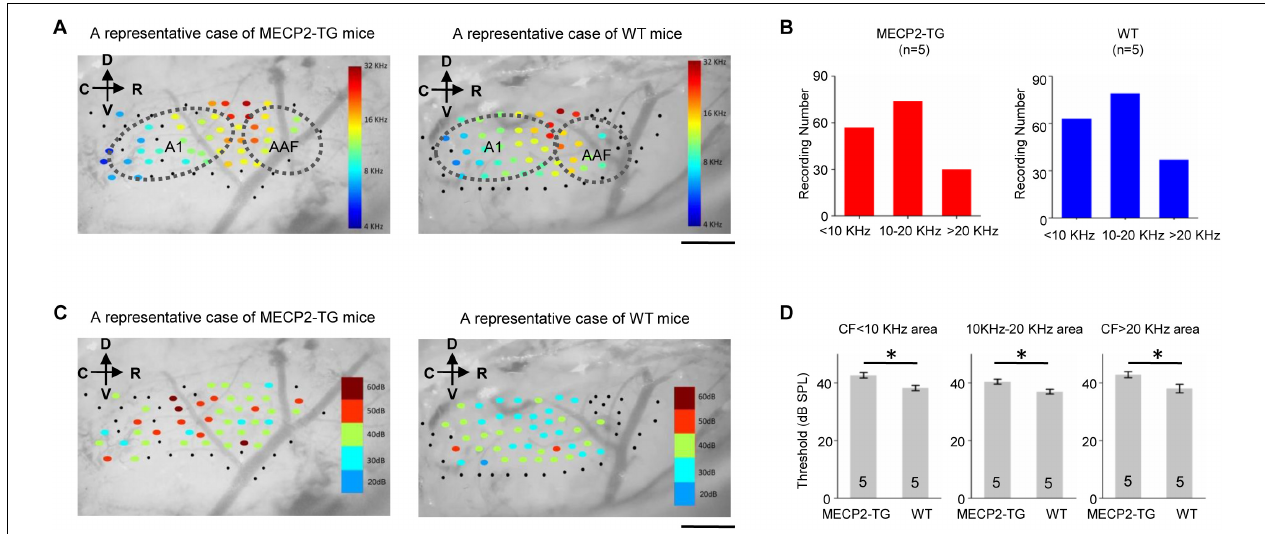
MECP2-TG mice ( n = 5) and 174 recording sites from WT mice ( n = 5). (C) Example cortical threshold map from the auditory cortex of MECP2-TG mice and WT mice. Black dots indicate that there was no response at the recording site. Scale bar, 0.5 mm. (D) Average intensity threshold at CF of low-frequency regions,